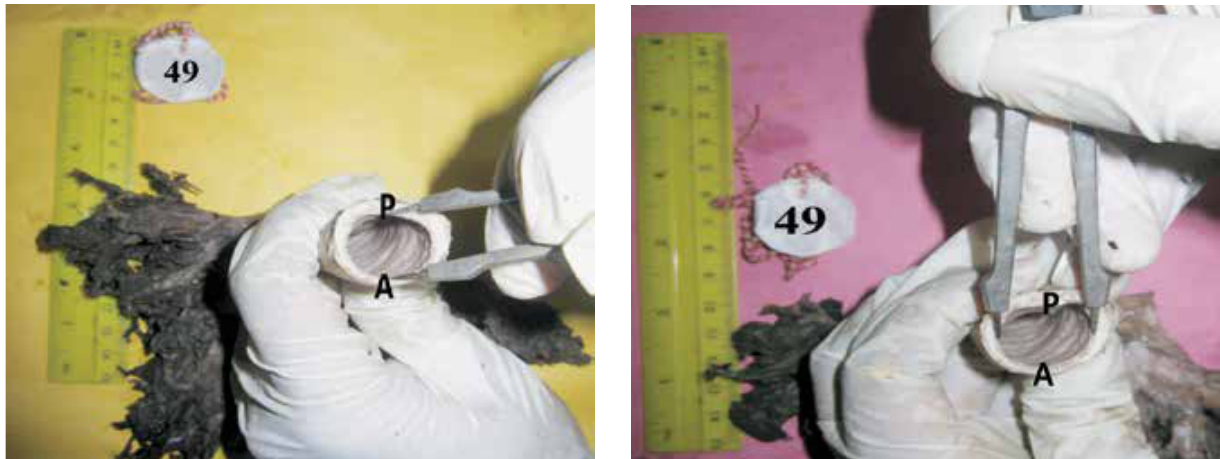
Fig 1: Photograph showing the procedure of measurement of luminal diameter of the trachea. A, anterior; P, posterior